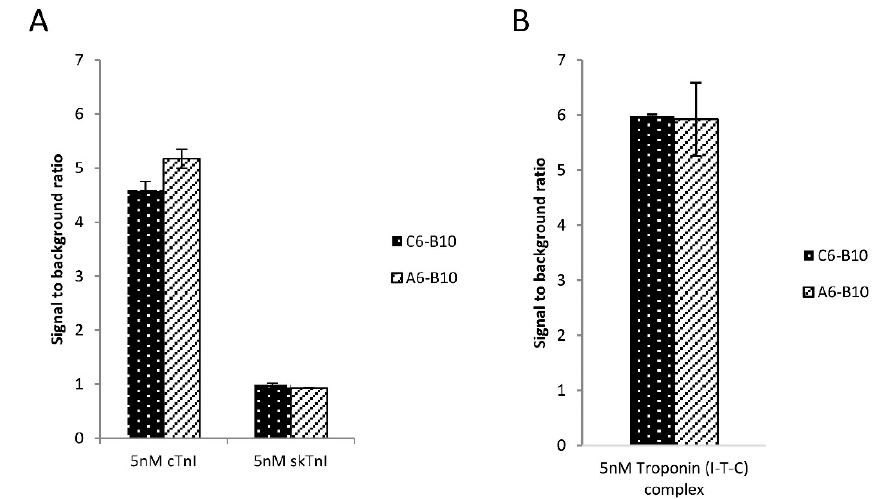
Figure 3. Selective detection of cTnI monomer and ternary complex by spiegelmer based sandwich assay. ( A ) Ten times diluted cTnI depleted human plasma was spiked with 5 nM recombinant cTnI and sTnI and analyzed by AlphaLisa in a dedicated plate reader using the N-terminal B10 and the C-terminal epitope selective A6, C6 spiegelmers. ( B ) The selection buffer was completed by the addition of 5 nM human I-T-C ternary complex and analyzed as in panel A.